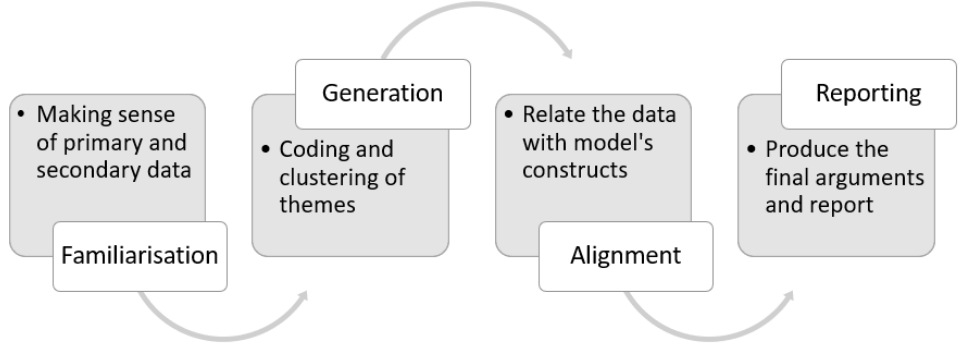
Figure 4. Thematic analysis process.